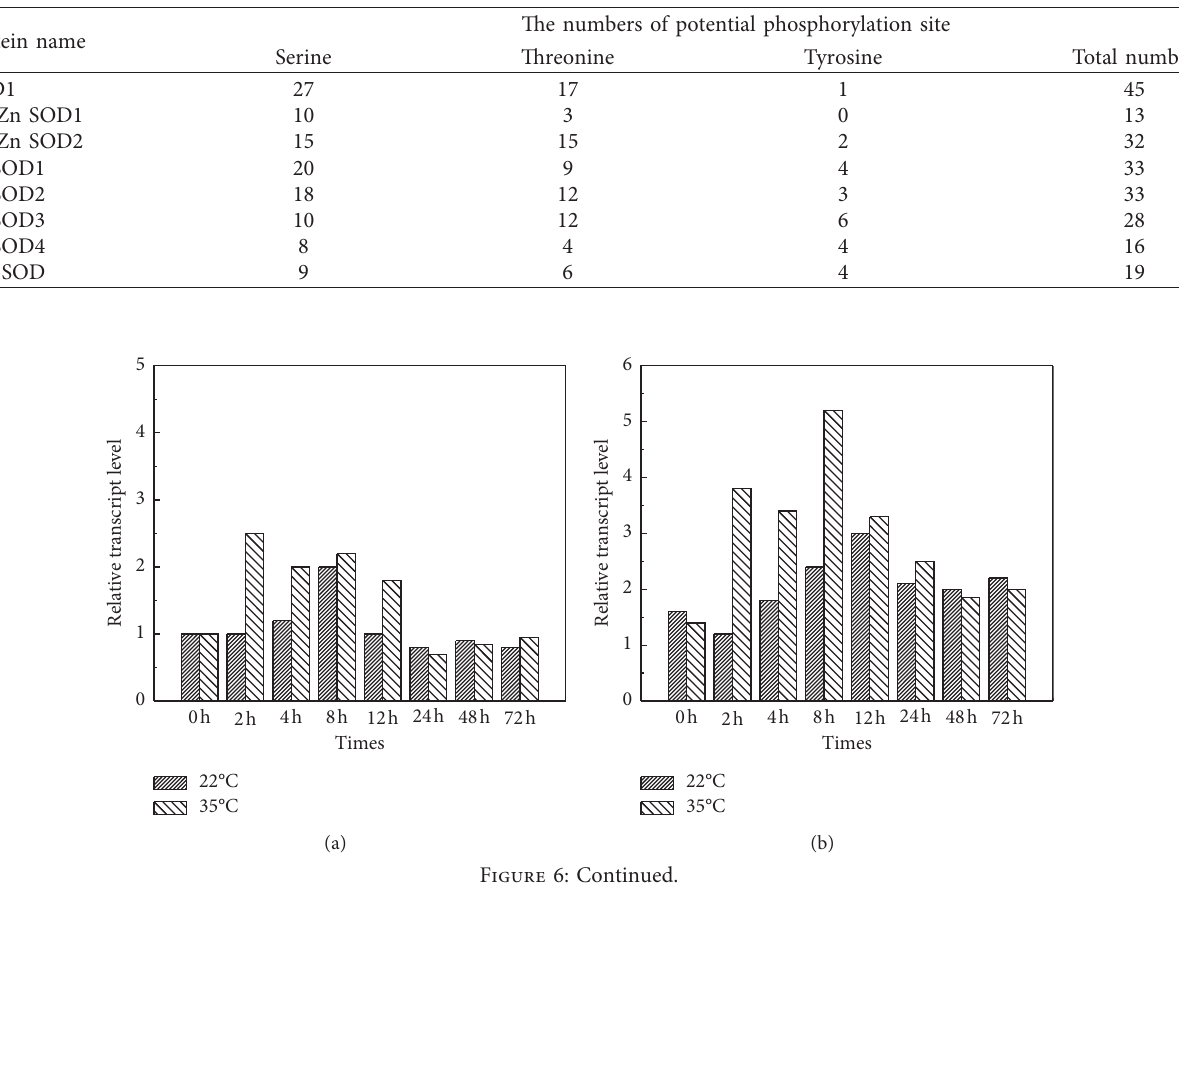
Table 3: Prediction of phosphorylation sites of the potato SOD genes.